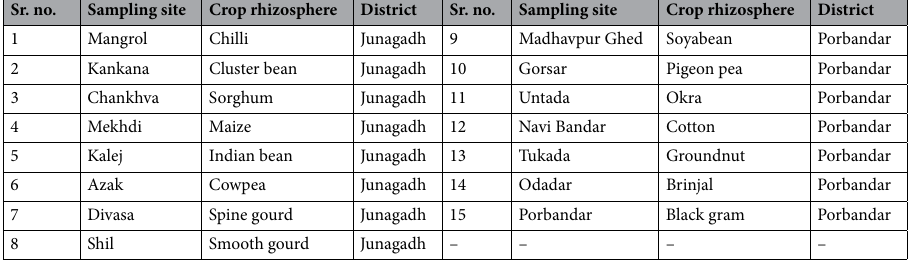
Table 11. Details of soil sampling sites and